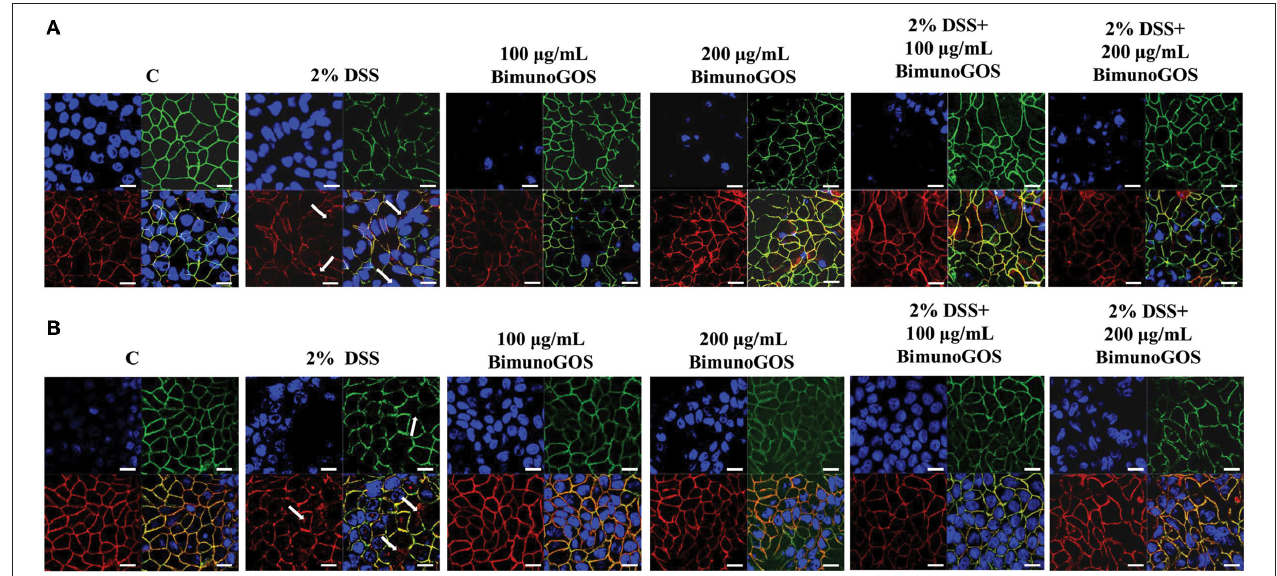
FIGURE 8 | Localization of tight and adherent junction proteins in Caco-2 cells. Cells were either untreated (C), or treated with 2% DSS for 6h, or treated with Bimuno GOS (100 or 200 µ g/ml) for 4h, or treated with 2% DSS for 2h and then with Bimuno GOS (100 or 200 µ g/ml) for further 4h. Cells were labeled with specific primary antibodies for tight (A) and adherent (B) junction proteins, followed by TRITC- and FITC-conjugated secondary antibodies for occludin and ZO-1, and for β -catenin and E-cadherin, respectively. Cell nuclei were stained with DAPI. Dissociation of occludin from the membrane is indicated by arrows. Each figure is representative of three independent immunofluorescence assays (63 × magnification). Bars represent 10 µ